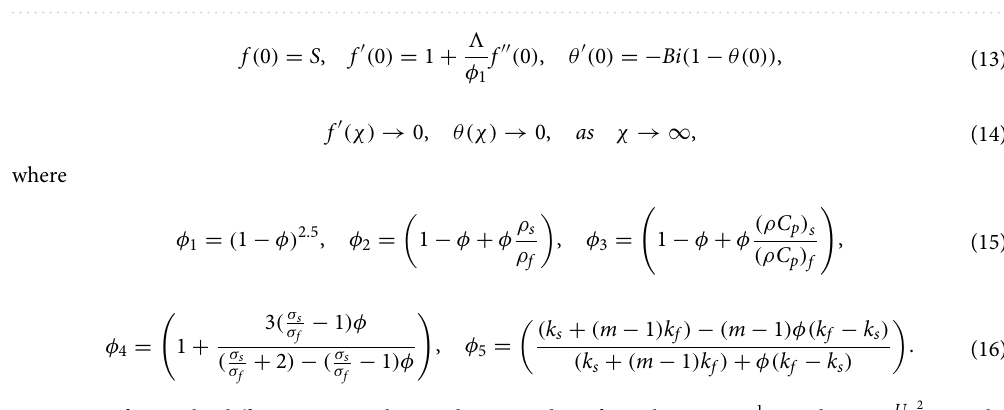
Figure 2. Keller-box method